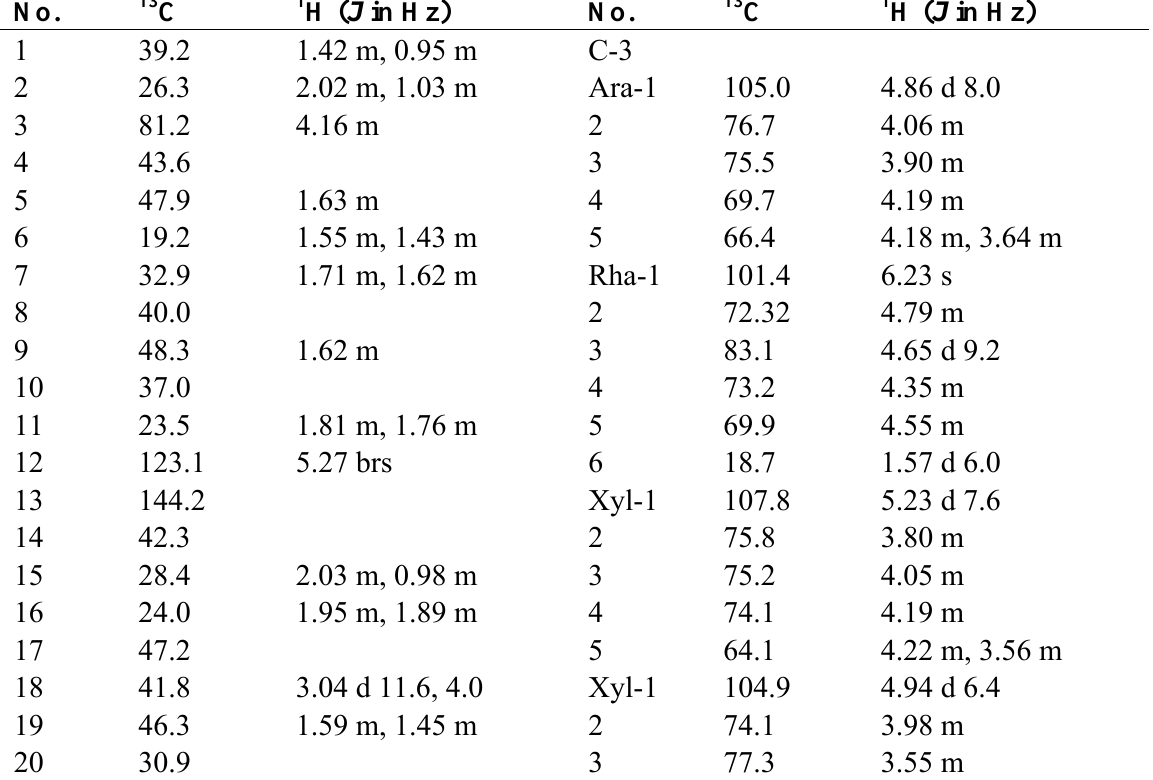
Table 1. 1 H-NMR and 13 C-NMR spectral data of compound 1 (recorded at 400/100 MHz in ; δ in ppm, J in Pridine-d 5